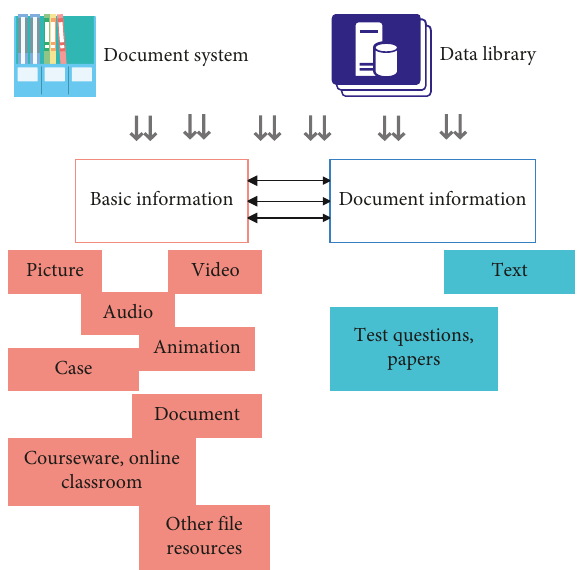
Figure 4: The storage structure of online teaching resources of spoken English.